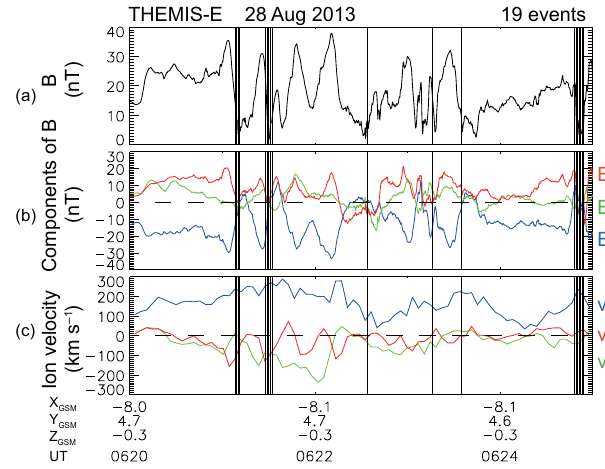
Figure 2. The two-step calculation to identify severe magnetic fluc- tuation events.